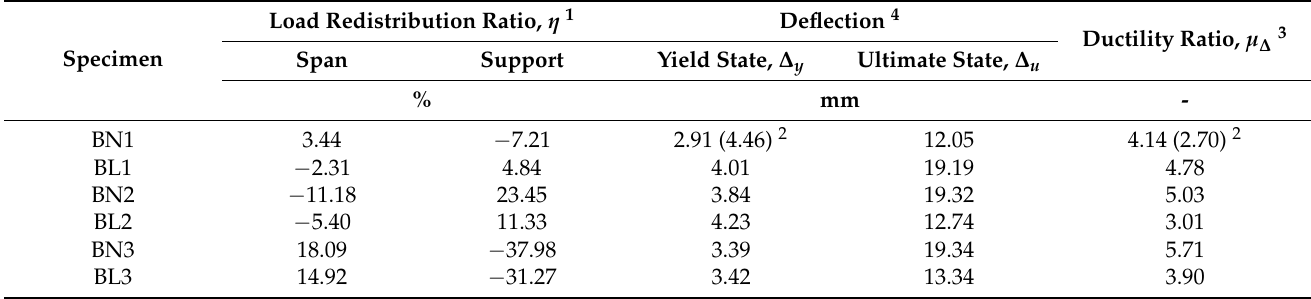
1 Negative value indicates that there was an increase of the moment value compared to the elastic analysis. 2 A value for the estimated yield load is given in brackets; see note 4 in Table 5. 3 Values were calculated for the mean values of deflection. 4 The mean value for both